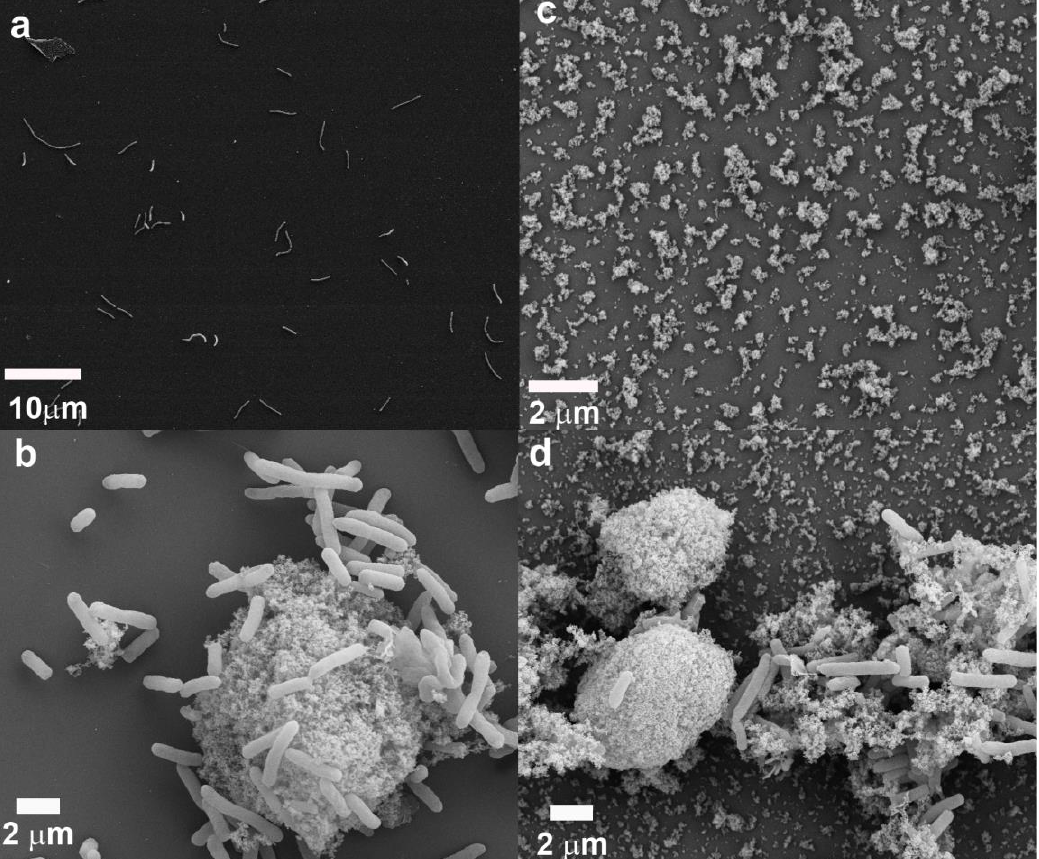
Figure 2. SEM images of E. coli cells and nanoparticles: ( a ) E. coli cells, ( b ) gold nanoparticles with E. coli showing the aggregation of nanoparticles and bacterial cells, ( c ) laponite nanoparticles, and ( d ) laponite nanoparticles with E. coli .